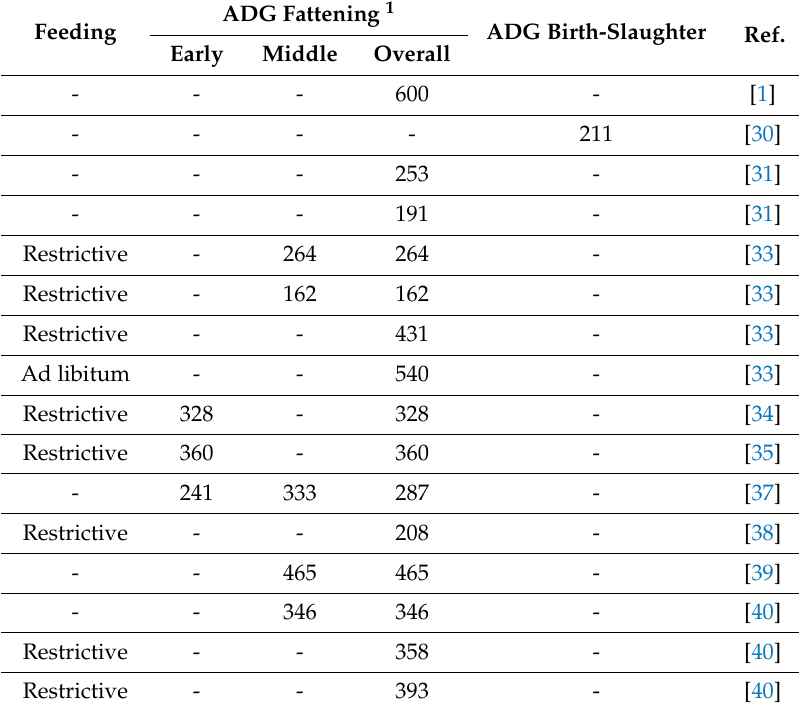
Table 2. Overview on growth performance in ad libitum and restrictive feeding.